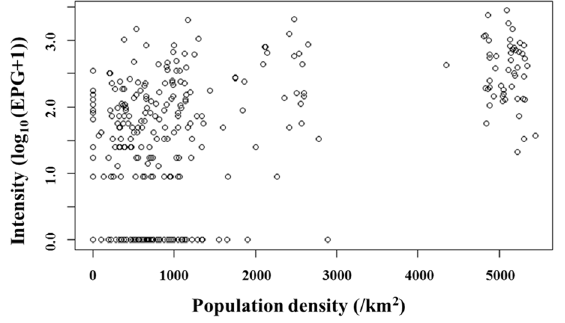
Figure 3. Relationship between local population density and intensity of S. mansoni infection. Scatter plot showing positive association between intensity of S. mansoni infection and population density. The population density and the intensity were expressed as the number of people within a radius of 1 km and log 10 (epg + 1),